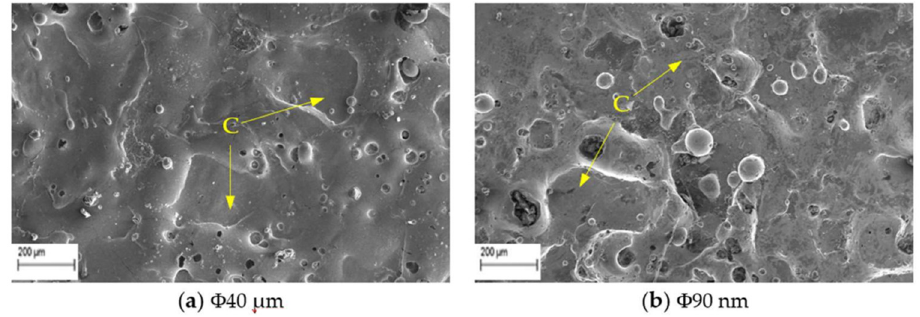
Figure 12. SEM micrograph of surface machined using T d = 300 μs, I p = 18 A, V g = 80 V